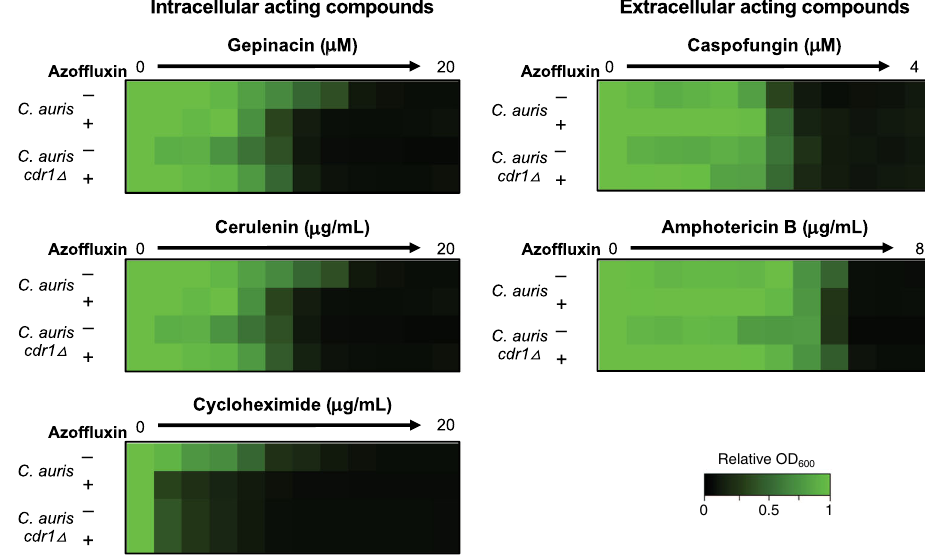
Fig. 3 Azof fl uxin potentiates intracellular acting compounds against C. auris , to a similar degree as deletion of CDR1 . Dose-response assays were conducted with a C. auris Ci6684 parental strain in the absence and presence of 25 µ M azof fl uxin where indicated, as well as with a strain with the ef fl ux pump gene CDR1 deleted. Indicated compounds were titered in a 2-fold serial dilution. Growth was measured after 24 h in YPD as described in Fig. 1e (see color bar). Source data are provided as a Source Data fi le.